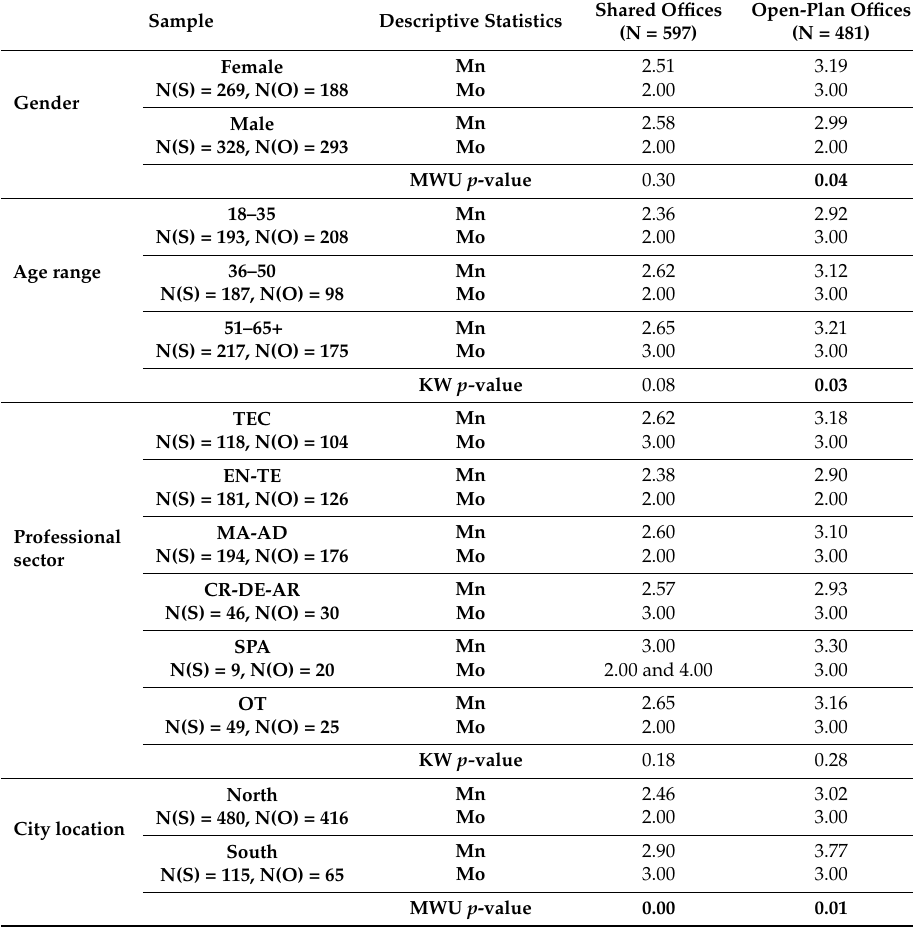
Descriptive Statistics